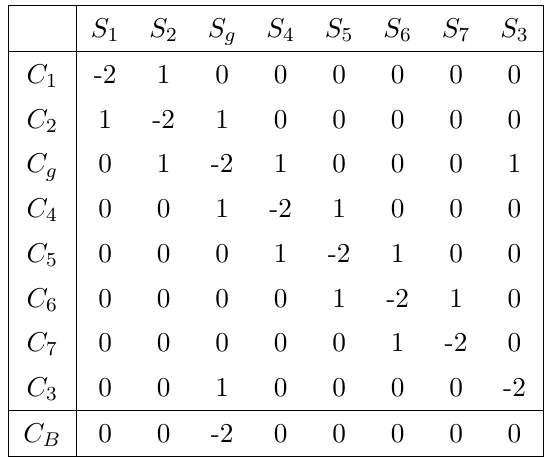
; 7 ; g and the (cid:1) (cid:1) (cid:1)